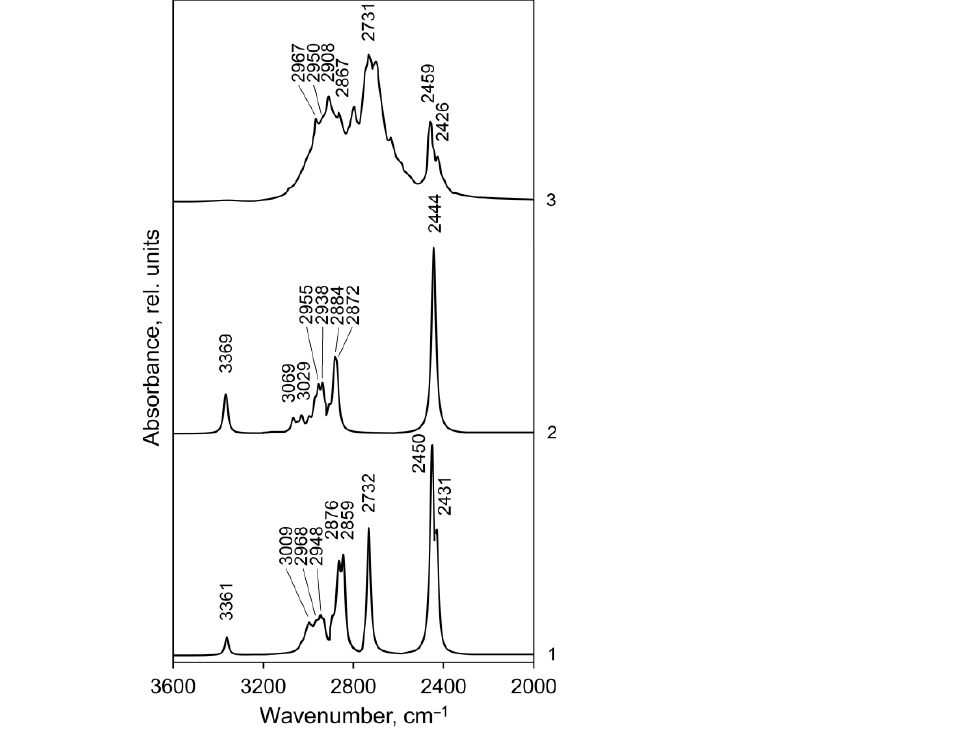
Figure 5. Calculated (curves 1 and 2) and experimental (curve 3, [48]) IR spectra of methylone hydrochloride in the 3600–2000 cm − 1 range: curve 1—IR spectrum for dimer 1, curve 2—IR spectrum for dimer 2. The line half-width is 10 cm − 1 .